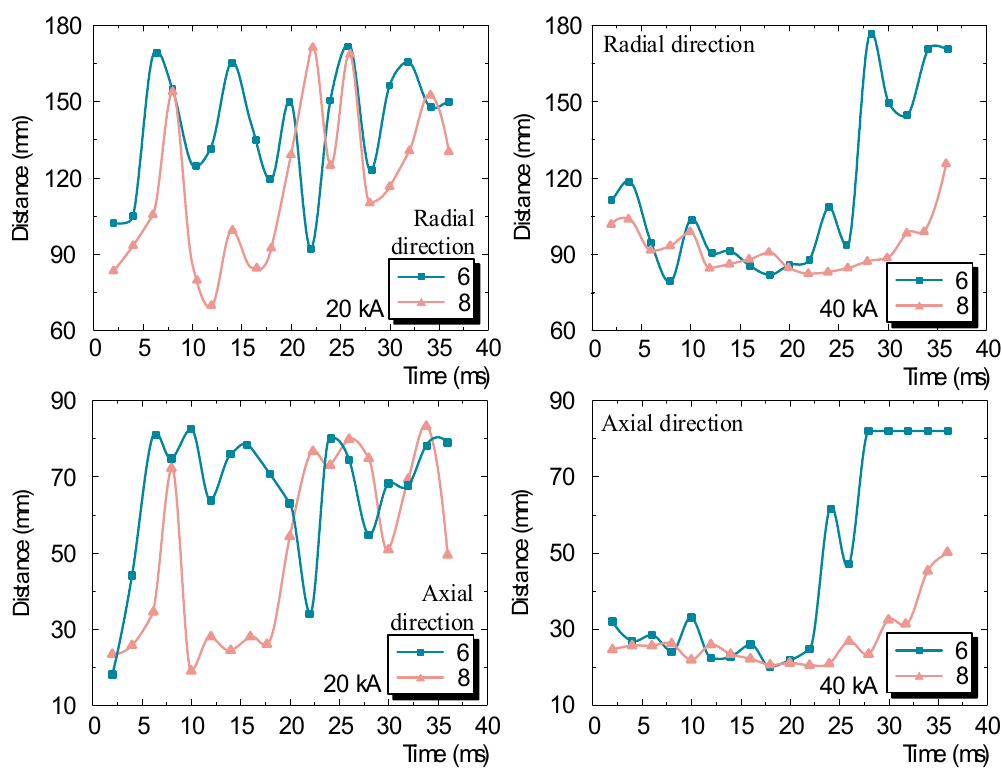
Figure 15. A comparison of arc diffusion under different electrode structure design with different numbers of the spiral-shaped petal at different current levels.